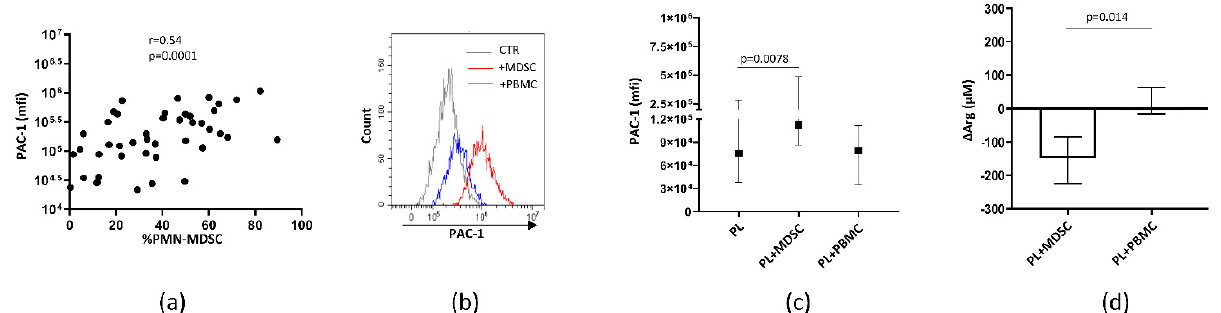
Figure 2. PMN-MDSC induced platelet activation by reducing L-arginine. ( a ) Correlation between PAC-1 platelet expression (mfi) and PMN-MDSC percentage from SARSCoV-2 infected patients (ICU n = 21, no ICU n = 15) and HD ( n = 9). Non-parametric Spearman correlation was applied. ( b ) Representative histogram plot showing PAC-1 expression on platelets after culture with or without PMN-MDSC or PBMC depleted from MDSCs (PBMC). ( c ) PAC-1 expression on platelets from HD ( n = 6) after culture with PMN-MDSC or PBMC from SARSCoV-2 infected patients ( n = 6). Results are shown as median and IQR. Wilcoxon matched-pairs signed rank test was applied. ( d ) L-arginine reduction ( ∆ Arg) calculated as the difference between L-arginine concentration in the presence of MDSCs or PBMC and platelets alone. Results are shown as median and IQR. A Wilcoxon matched-pairs signed rank test was applied.